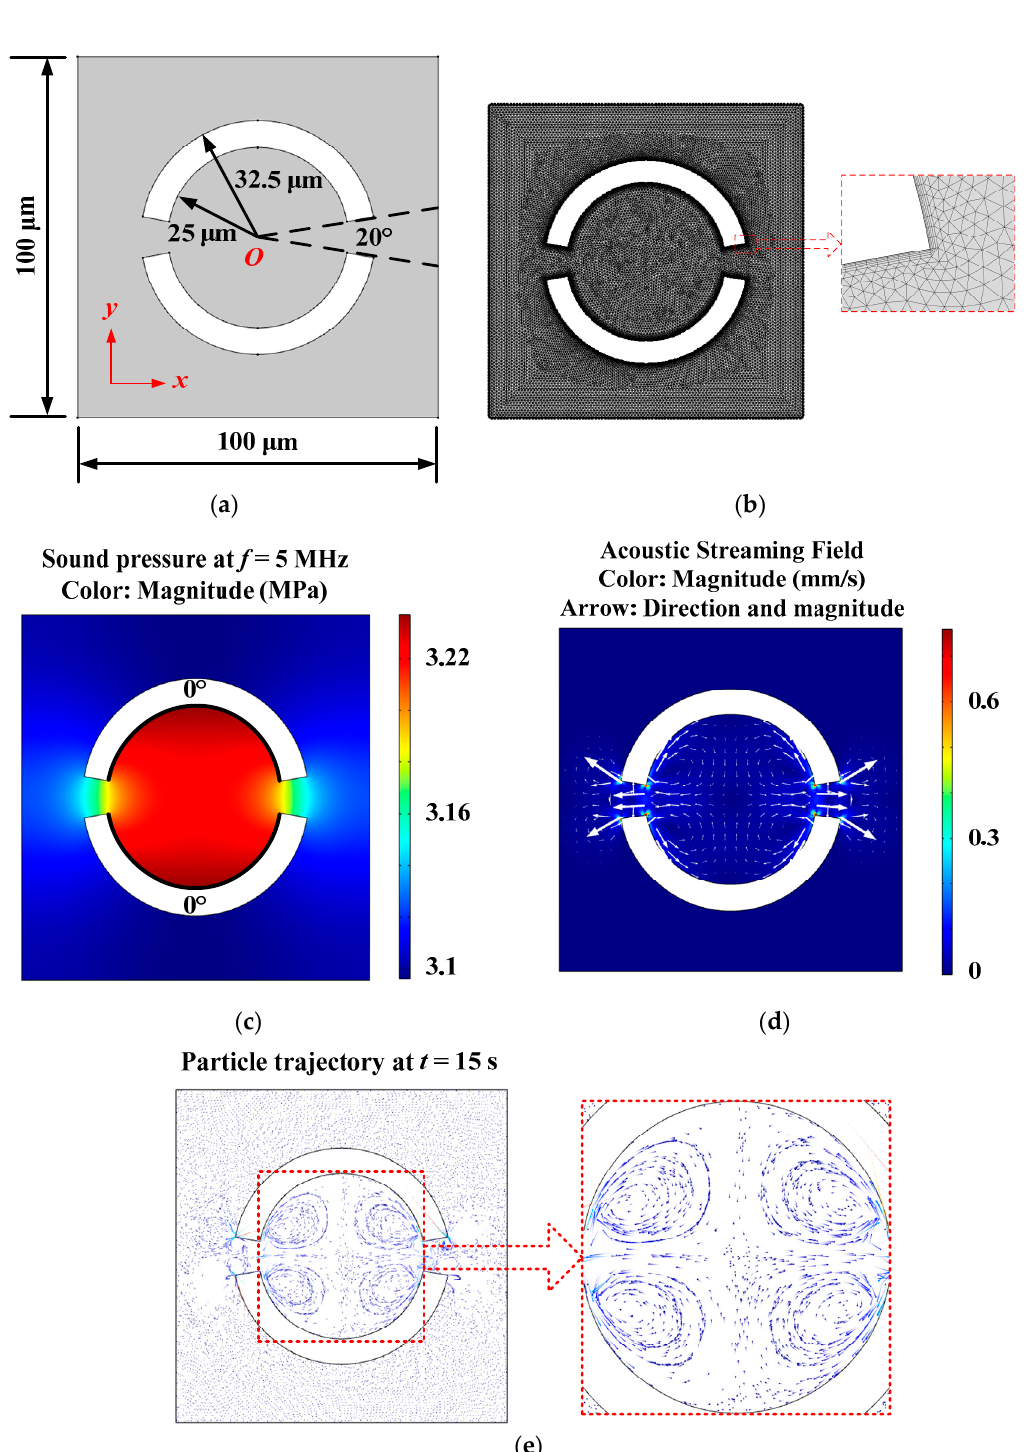
Figure 1. (Color online). Two-dimensional (2D) square model for the acoustofluidic field and particle trajectory excited by two vibration sources with the same frequency (5 MHz) and amplitude (1 nm). ( a ) Computational model. ( b ) Meshed model for the acoustofluidic field and particle trajectory. ( c ) Pattern of sound pressure field. ( d ) Pattern of acoustic streaming field. ( e ) Pattern of microparticle trajectory at a given time (15 s).